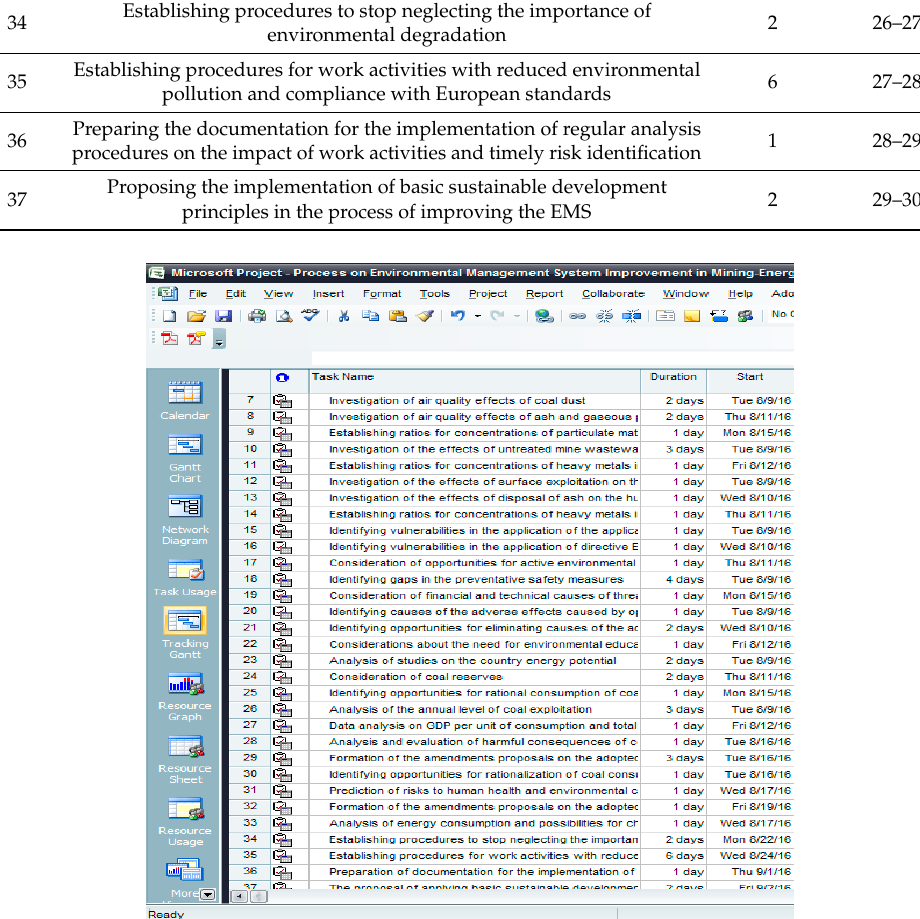
Figure 3. Time duration and order of execution of the project activities to improve environmental protection system in mining and energy complexes.